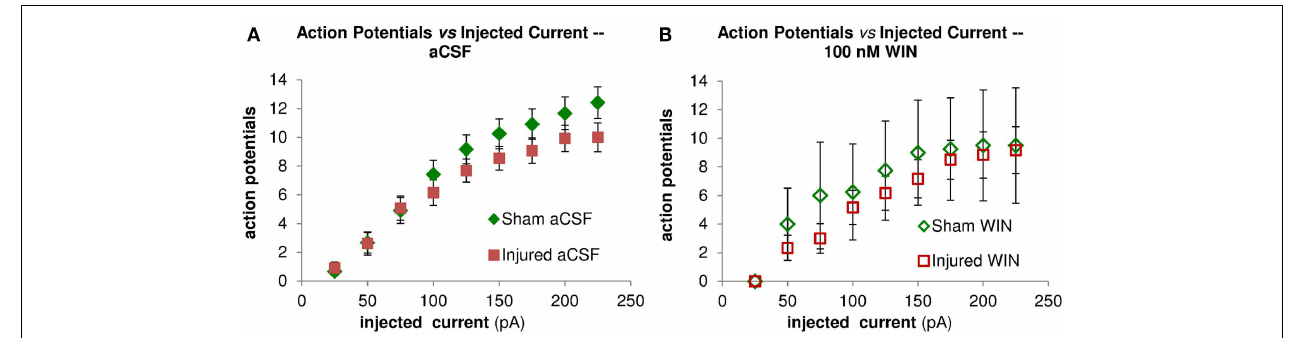
FIGURE 10 | Repetitive action potential (AP) firing is not altered by injury and is unaffected by treatment with the cannabinoid agonist WIN55,212-2 . CA1 Pyramidal neuron voltage response to current injection through recording electrode. (A) Average AP frequency in response to depolarizing current steps (0–225pA, in 25pA increments) in aCSF. No significant differences in AP frequency were found between sham ( n = 13) and injured ( n = 13) pyramidal neurons at any of the current